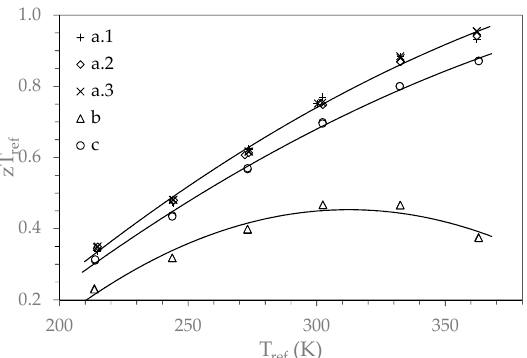
Figure 3. Measured dimensionless figure of merit for the investigated Peltier modules versus the test reference temperature.